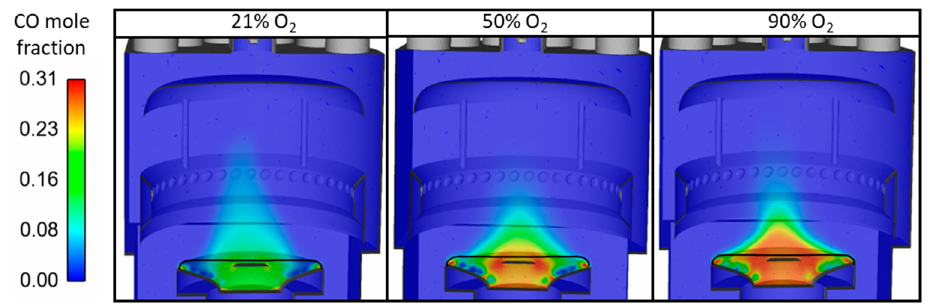
Figure 8. Contours of the CO mole fraction inside the boiler for the simulations of 21%, 50%, and 90% of oxygen in the inlets.